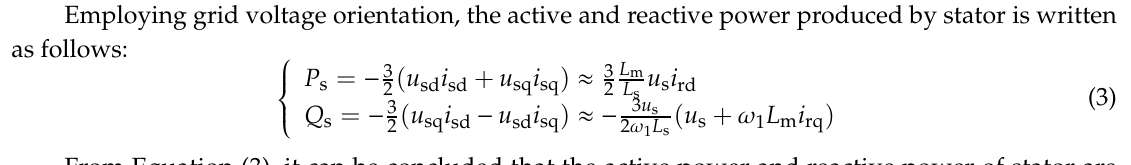
Figure 1. Structure of wind turbine driven by a DFIG.